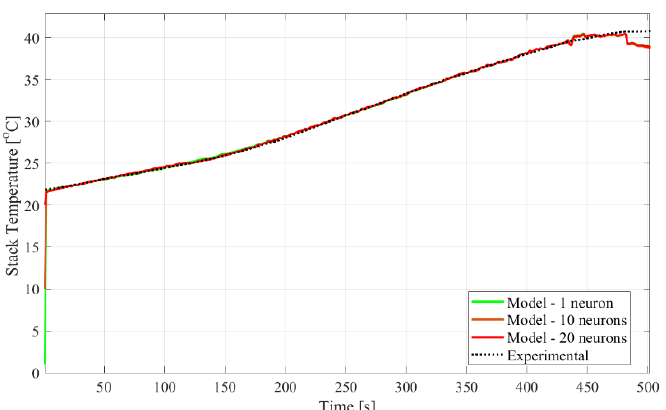
Figure 9. Experimental and model responses of the stack temperature using an ANN with the LM algorithm.